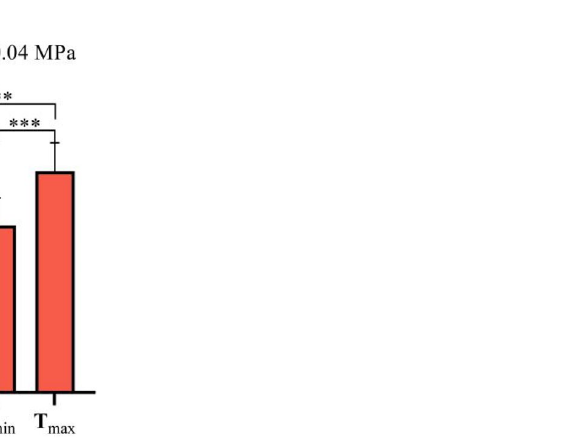
Figure 5. The mean temperature series of all temperature measurements collected during the experiment, averaged for each time point. The curve was obtained from these average temperature values (mean ± SEM) based on smooth spline fitting.